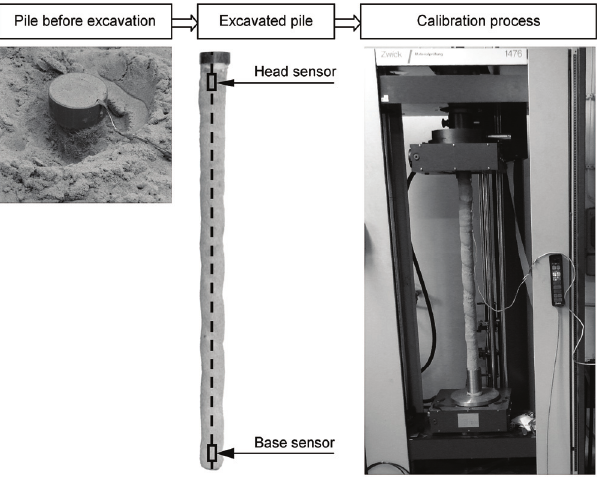
Fig. 1. Model pile calibration and sensors localization in pile